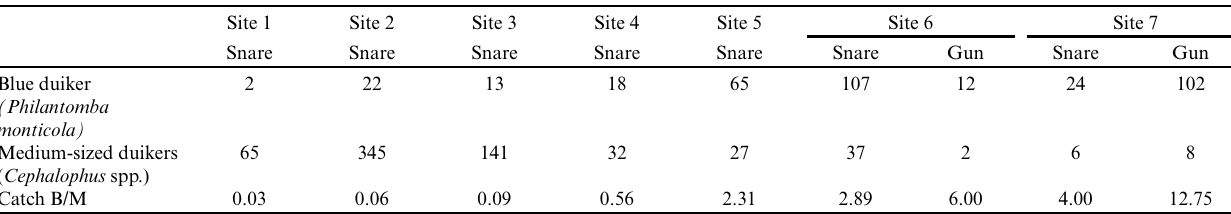
Table 6 . Catch of blue and medium-sized duikers and catch B/M at sites 1–7.